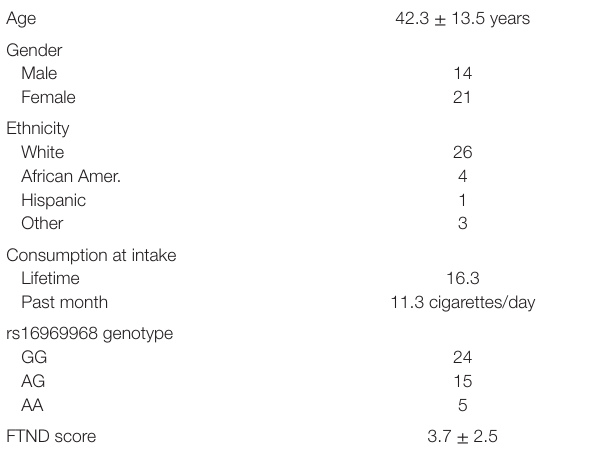
TaBle 1 | clinical characteristics of the study